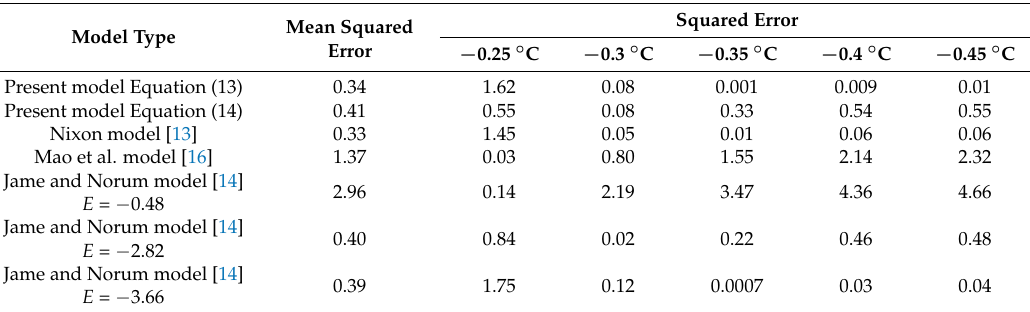
Table 3. Comparison results between various